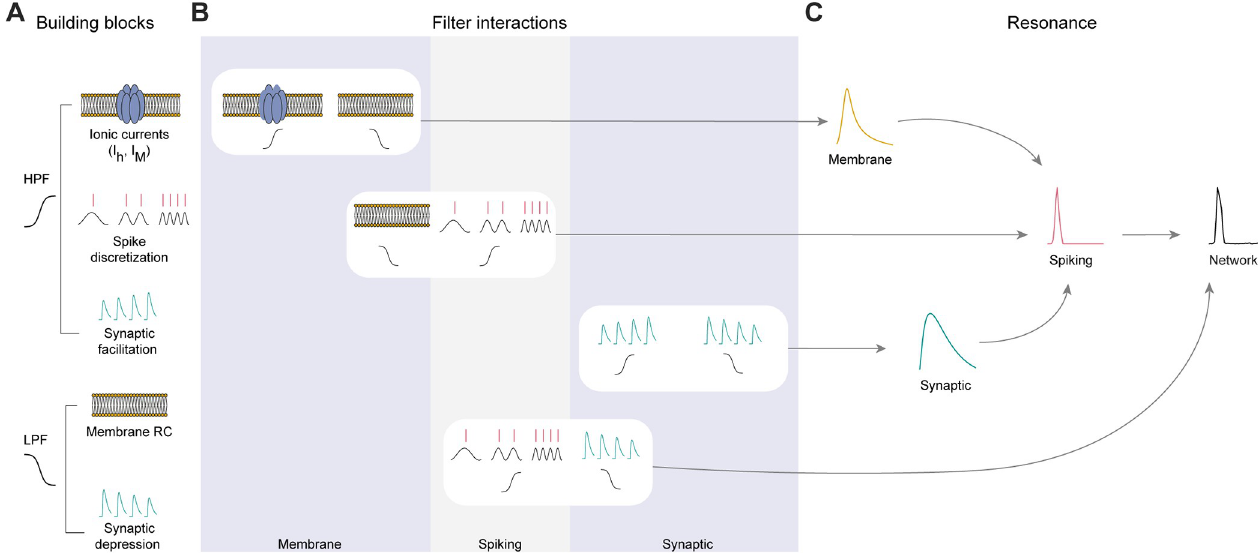
Fig 9. Network resonance can be generated by interacting low- and high-pass filters across levels of neuronal organization. ( A ) Frequency-dependent building blocks include high-pass filters (HPF, top) and low-pass filters (LPF, bottom). HPFs include inductive/resonant ionic currents ( I 8 ), acting at the level of membrane potential fluctuations; spike discretization and calcium-dependent spiking ( Figs 3, 4, 6 ); and synaptic facilitation and temporal summation ( Fig 5 ). LPFs include membrane capacitance and leak current ( Figs 2–4, 7, 8 ), and synaptic depression ( Figs 5, 6 ). ( B ) The frequency- dependent building blocks (filters) can interact either within the same level of organization (e.g., top row: membrane potential fluctuations; third row: postsynaptic potentials) or across levels of organization (e.g., second and fourth rows). ( C ) Interaction of HPF and LPF (within or across levels of organization) can generate resonance. If the interaction is within the same level of organization (e.g., membrane potential fluctuations), resonance can be generated at that level, and may (under certain conditions) be inherited to the network level (top pathway). Alternatively, network resonance may be generated intrinsically, by HPF and LPF across levels of organization (bottom